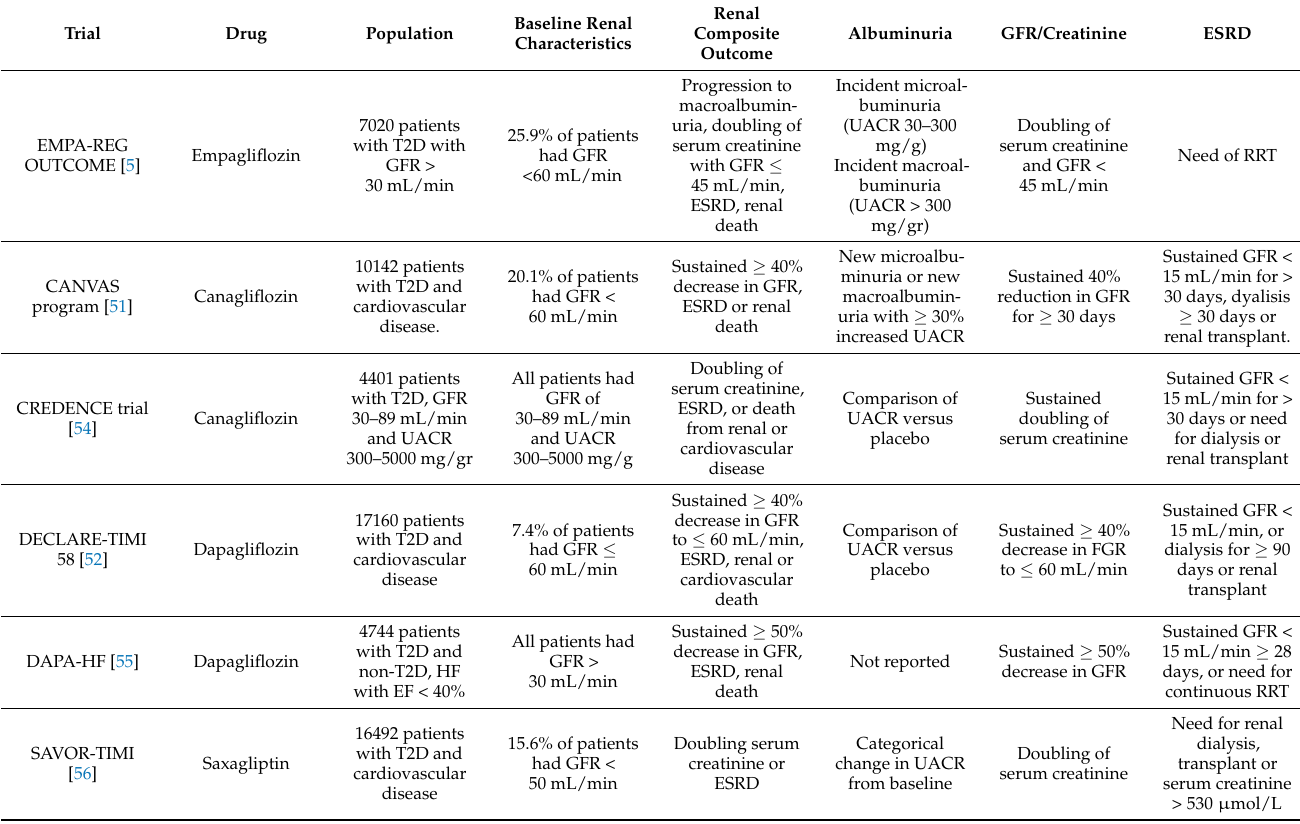
Table 3. Principal baseline characteristics and major renal outcomes of interest in the recently published type 2 diabetes outcome